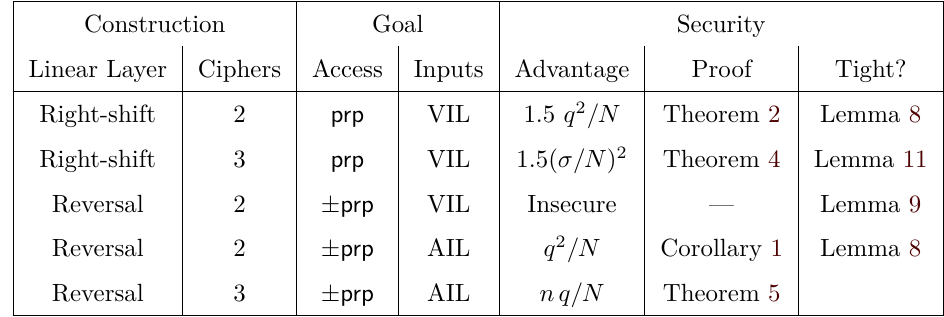
Table 1: Simplified upper bounds on adversarial advantage against our constructions, where a small advantage implies a secure scheme. Results are parametrised by the maximum number of queries q of total length σ blocks, the blocksize N and n = log N .